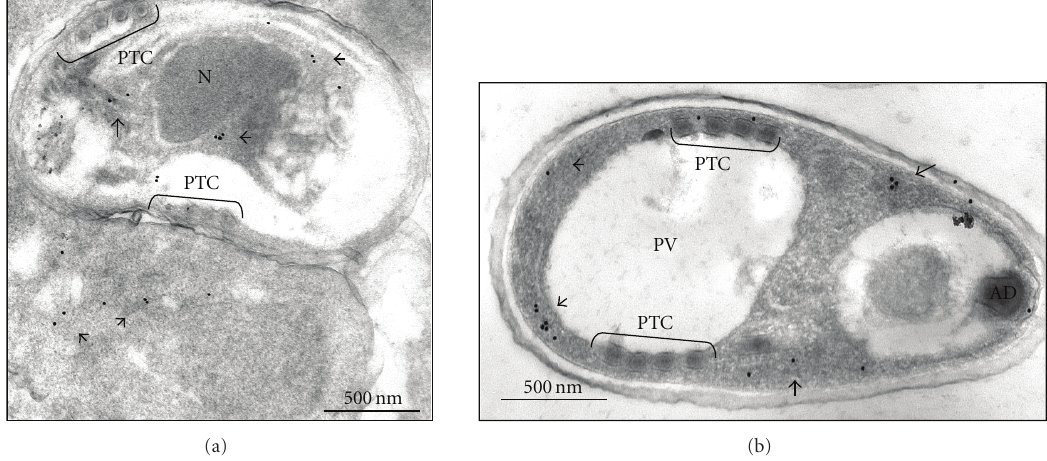
Figure 2: Immuno-TEM of E. cuniculi infected rabbit kidney cells. The infected cells were prepared according to the protocol described. Ultrathin Lowicryl resin sections were cut and reacted with C1 Hsp70 specific antibodies (1: 10) and a secondary antibody conjugated to 15-nm gold particles (1: 200). The developmental stages include immature meronts and sporonts (the lower and upper spores in (a), resp.) and a mature spore (b). Abbreviations are as follows: PTC, polar tube coil; N, nucleus; PV, posterior vacuole; AD, anchoring disk. Each bar indicates a 500-nm